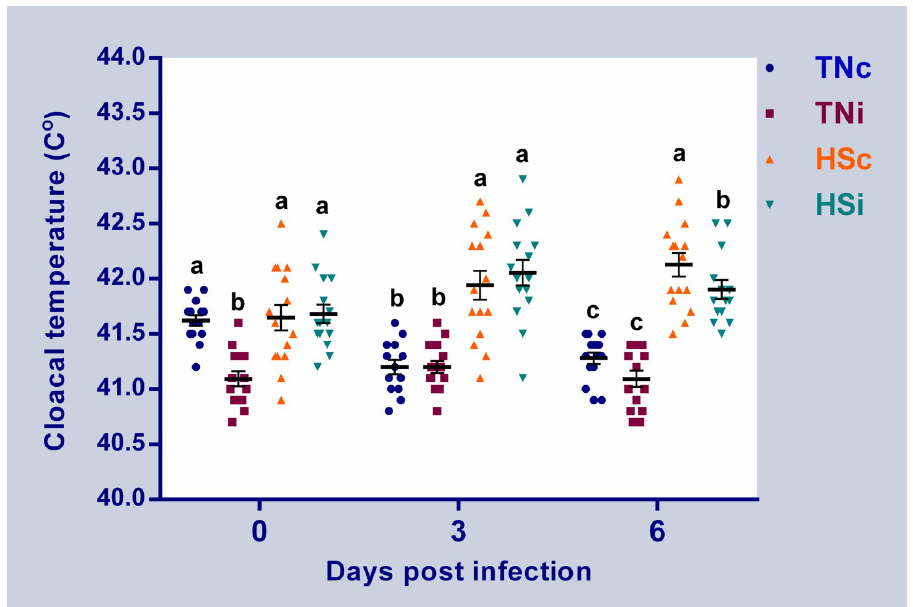
Fig 1. Cloacal temperature. Cloacal temperature of chickens infected with E . maxima and their uninfected controls that are raised in a thermoneutral or heat stress environment: TNc = thermoneutral control, TNi = thermoneutral infected, HSc = heat stress control, HSi = heat stress infected. Significant differences (p < 0.05) were depicted by different letters. The error bars represent the SEM.